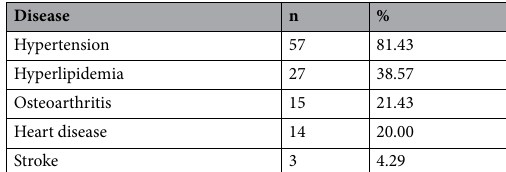
Table 1. Major Diseases in Long-Lived Participants.